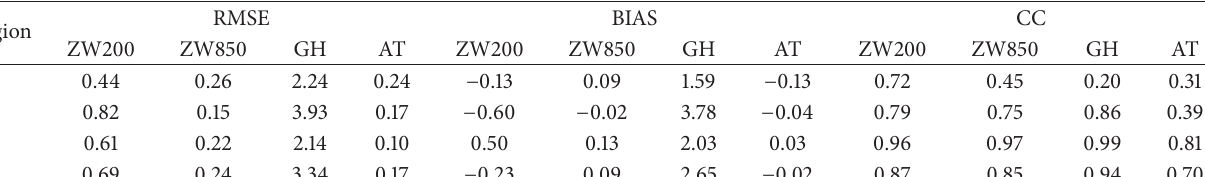
Table 4: Area averaged root mean square error (RMSE) and bias and spatial correlation coefficient (CC) for the zonal wind (ms − 1 ) at 200 hPa (ZW200) and 850 hPa (ZW850), geopotential height (m) at 500 hPa (GH), and air temperature (K) at 925 hPa (AT) anomalies for HCSA poleward expansion cases over the first four regions of Figure 5.